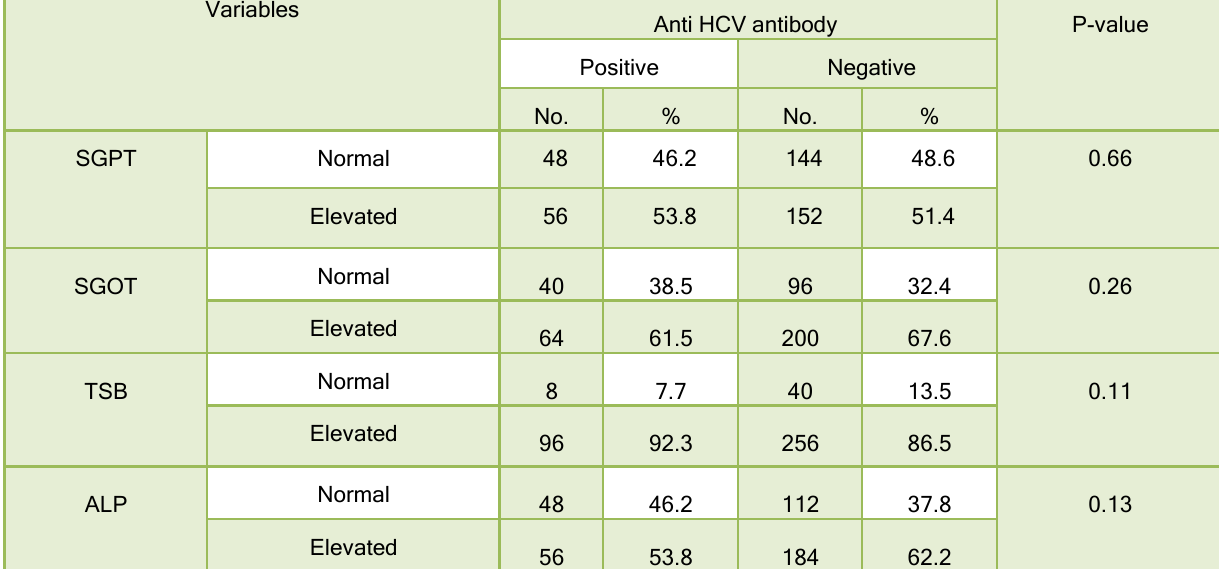
Table 8: The relationship of liver functional tests with occurrence of HCV.